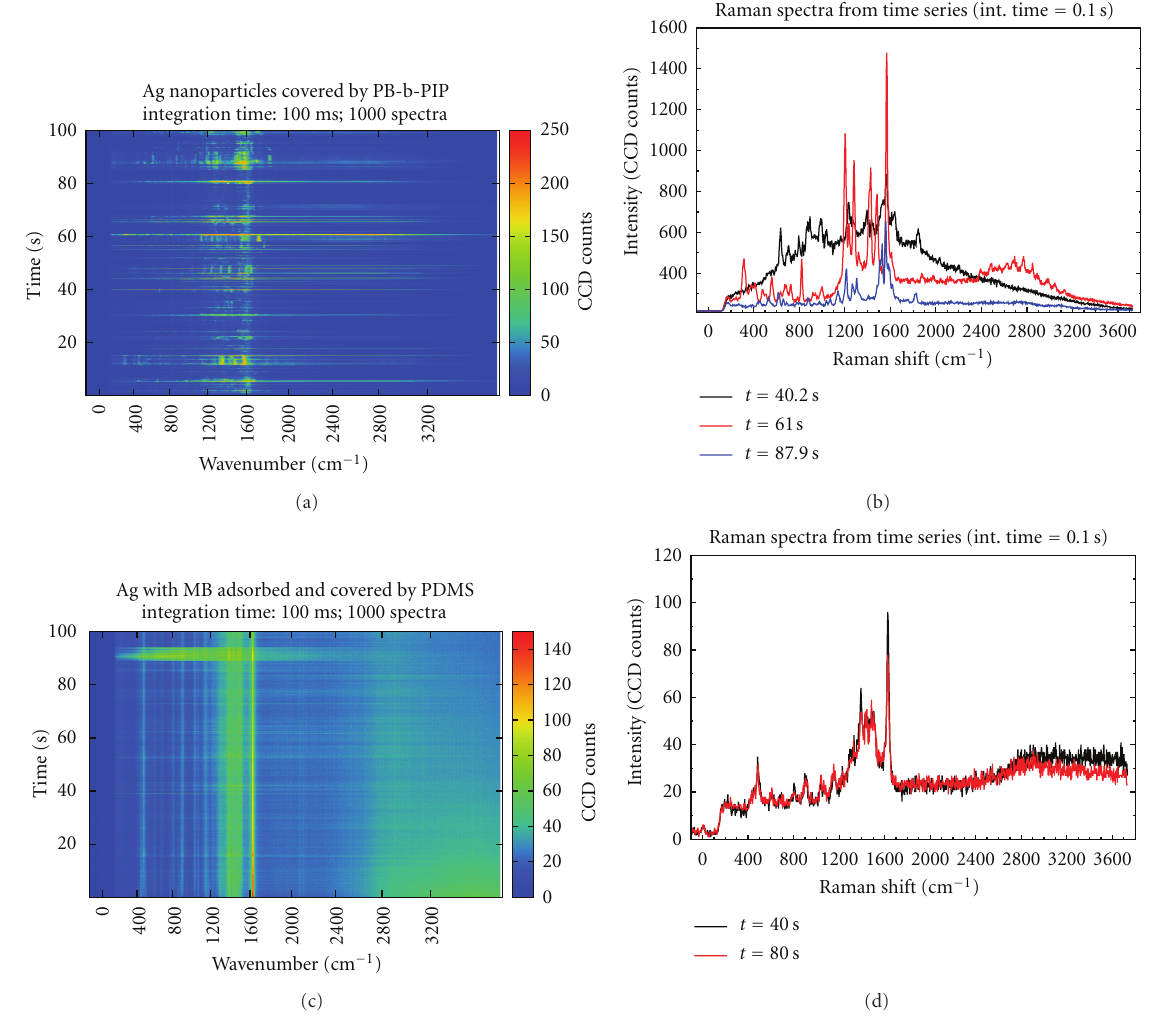
Figure 9: (a) Time series of Raman spectra acquired at a fixed focal point of a sample of Ag nanoparticles covered by a film of the block copolymer PB-b-PIP. Three spectra extracted from the time series are plotted in (b). The strong spectral and intensity fluctuations are not correlated to the Raman spectrum of PB-b-PIP. In (c), a time series of Raman spectra was acquired from a fixed focal point of sample of Ag nanoparticles with methylene blue adsorbed and covered by PDMS. In (d), SERS spectra of MB molecules present stationary